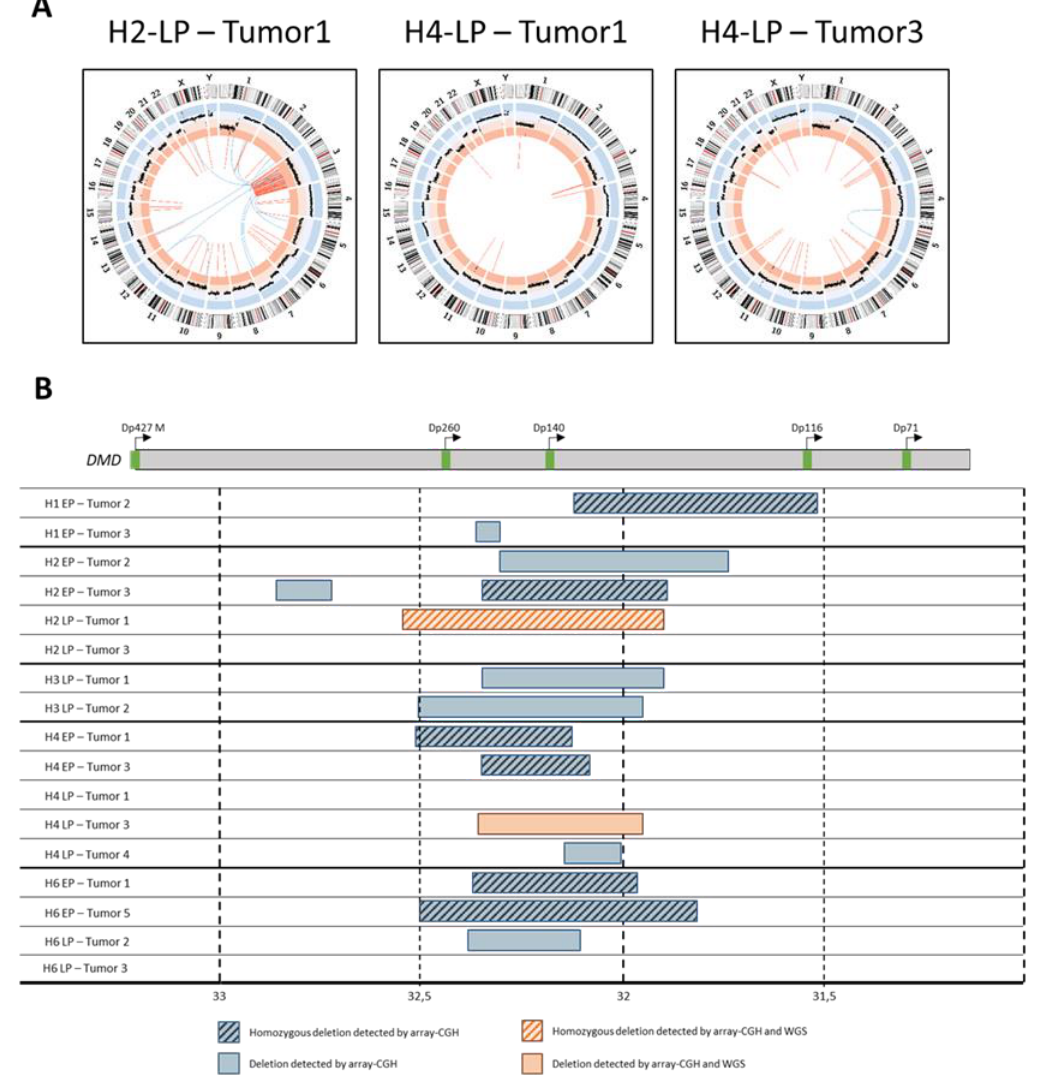
Figure 5. Hybrid tumors present complex chromosomic rearrangement including specific DMD deletions. ( A ) Circos plots representing chromosome ideogram, CNV and inter (blue) and intra-chromosomic (orange) structural variations. ( B ) DMD deletions overview of hybrid tumors. At top, a schematic representation of DMD transcripts. At bottom, blue boxes represent deletions detected by array CGH, and orange box deletions detected also by WGS and validated by PCR and Sanger sequencing.